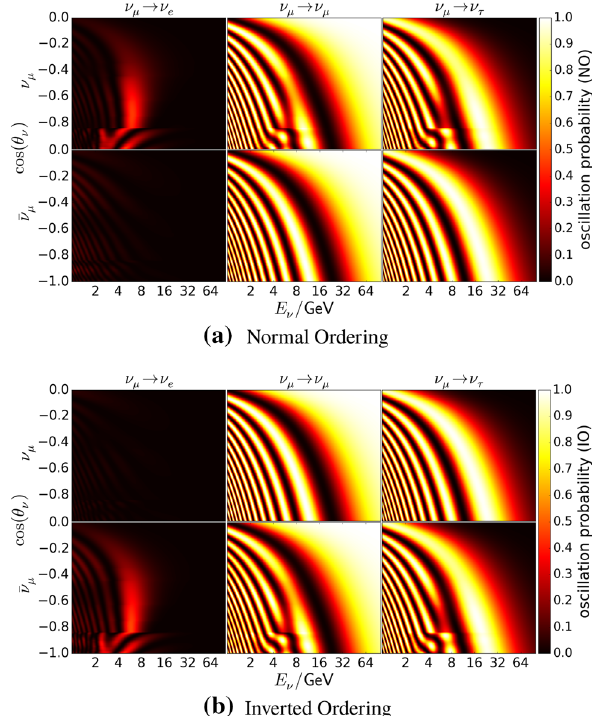
Fig. 2 Oscillation probabilities for an atmospheric ν μ or ν μ upon reaching the IceCube detector, as a function of the cosine of the zenith angle, θ ν , and the energy, E ν , of the neutrino, for the NO ( a ) and the IO ( b ) hypotheses. The probabilities are shown for the neutrino appearing as each of the three possible flavors, with the neutrino and anti-neutrino cases shown as the top and bottom rows in each panel. The dominant mixing of ν μ and ν τ is clearly visible, while the ν e flavor is mostly decoupled, except for a small contribution from matter effects below E ν ∼ 15GeV